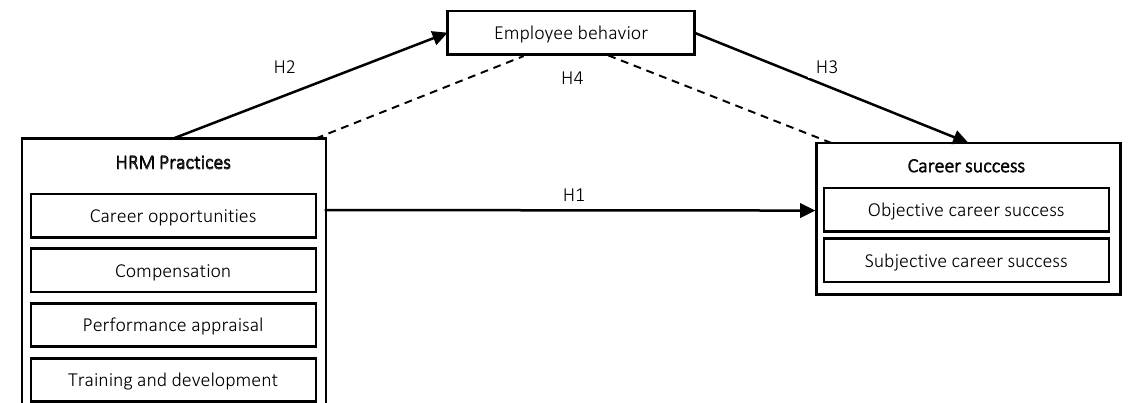
Figure 1. Theoretical